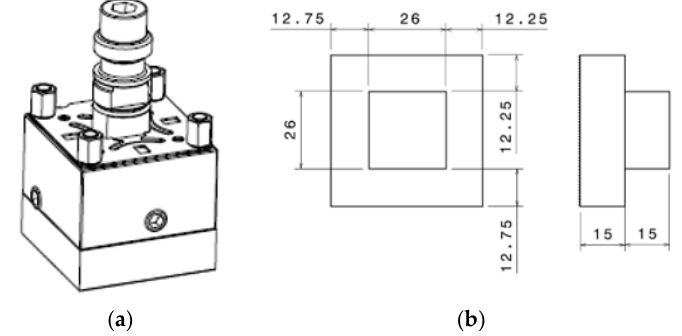
Figure 7. ( a ) EROWA ER-009222 electrode holder. ( b ) Electrode dimensions.